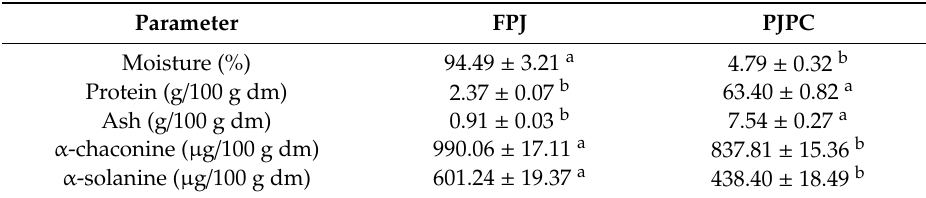
Table 1. Proximate composition.